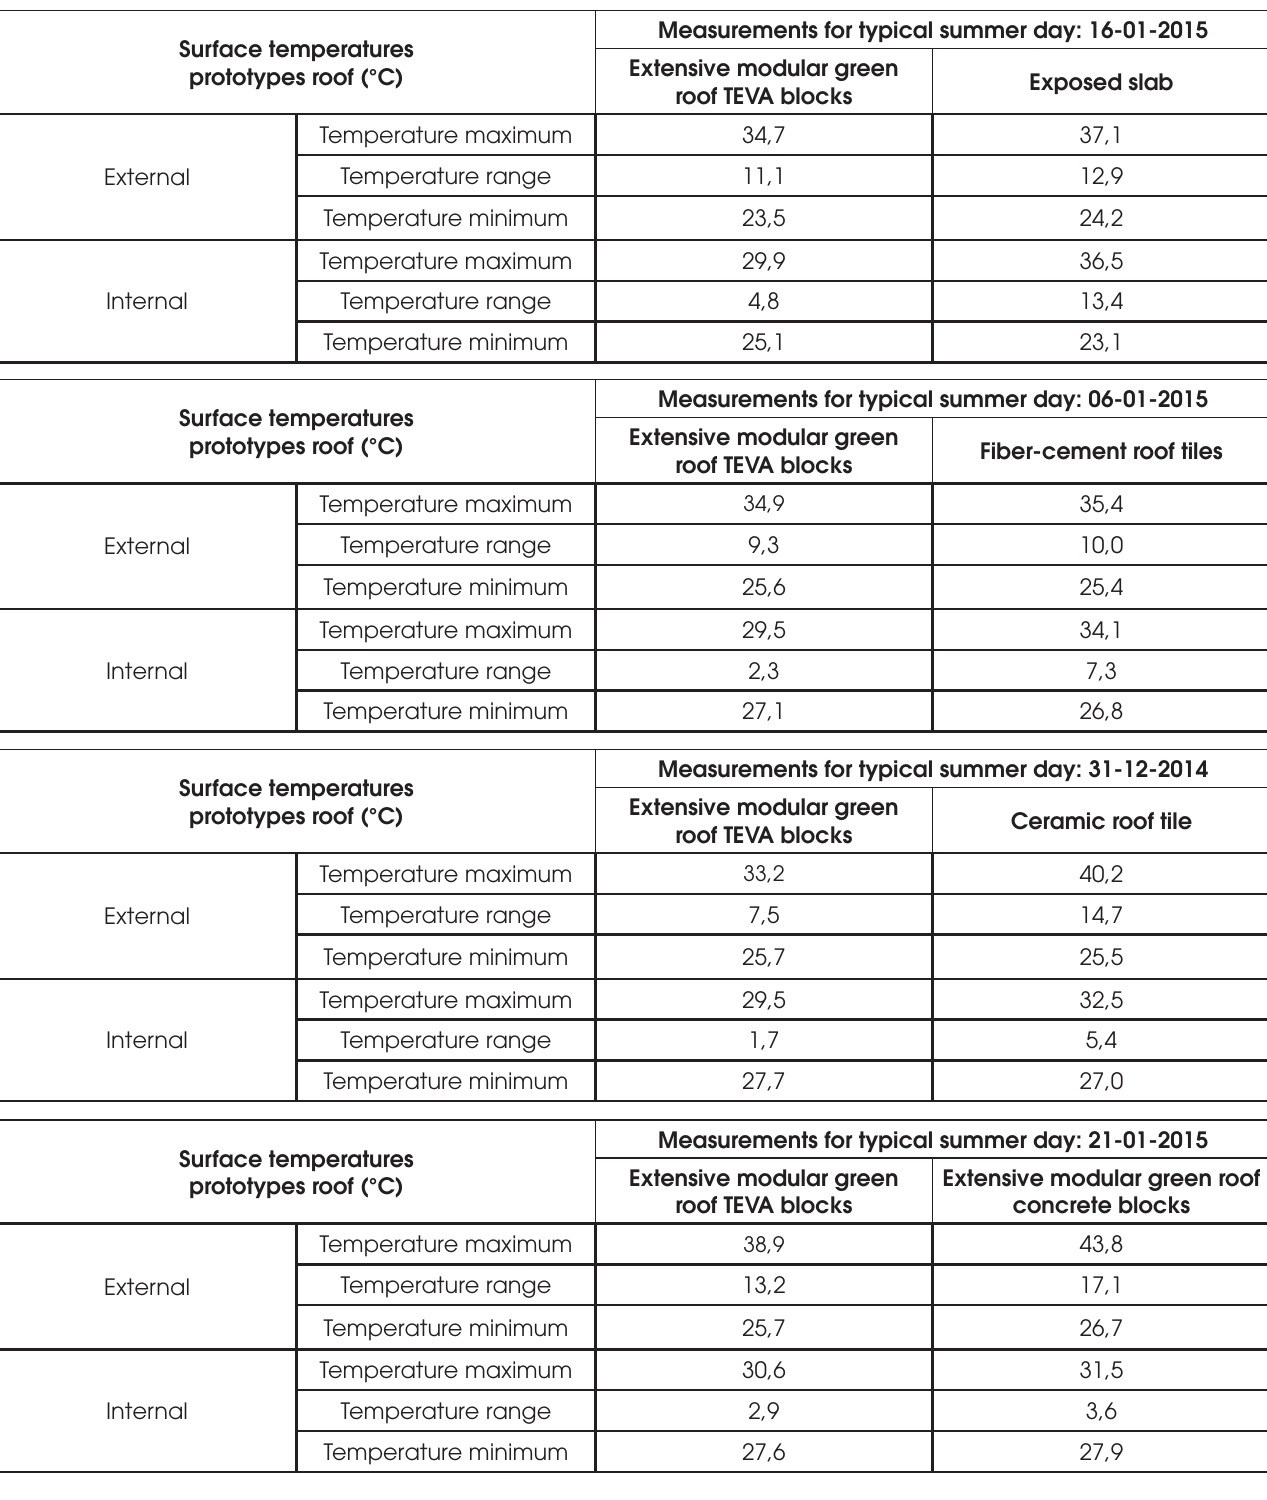
Temperature ranges for the internal and external surface temperatures of the roofs of the